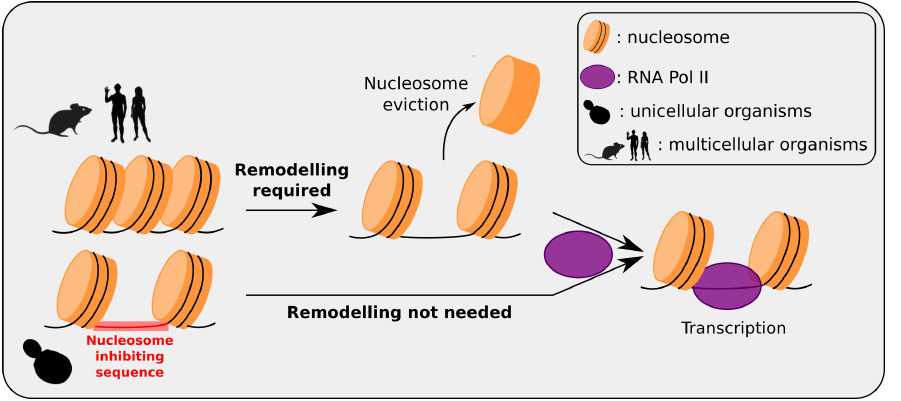
Figure 2. Multicellular/unicellular strategy for intrinsic nucleosomal organization at promoters. In human and most multicellular organisms, typical promoters are intrinsically occupied by nucleo- somes, with no inhibiting sequences at these loci; genes are “repressed-by-default” and activated only when needed by the active removal of a nucleosome at the promoter making it accessible to the transcription machinery. In unicellular Eukaryotes such as yeast, inhibiting sequences have been selected at typical gene promoters, to avoid nucleosome formation at these loci; genes are “activated-by-default” since promoters are directly accessible to the transcription machinery, avoiding a remodeling step. These different strategies can be understood as in multicellular organisms, most genes (except housekeeping genes) present tissue-specificity, whereas in a unicellular Eukaryotes most genes are susceptible to be used in every cell. (RNA Pol II is not drawn to